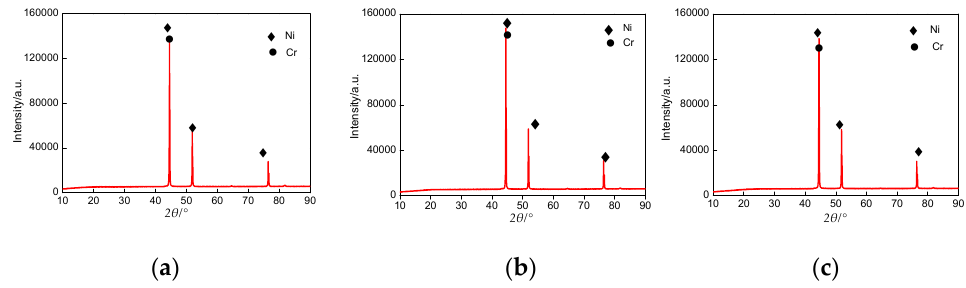
Figure 2. XRD patterns of Cr–Ni powders with different mass ratios of Cr and Ni. ( a ) XRD patterns of 17% Cr–83% Ni powder; ( b ) XRD patterns of 20% Cr–80% Ni powder; ( c ) XRD patterns of 24% Cr–76% Ni powder.